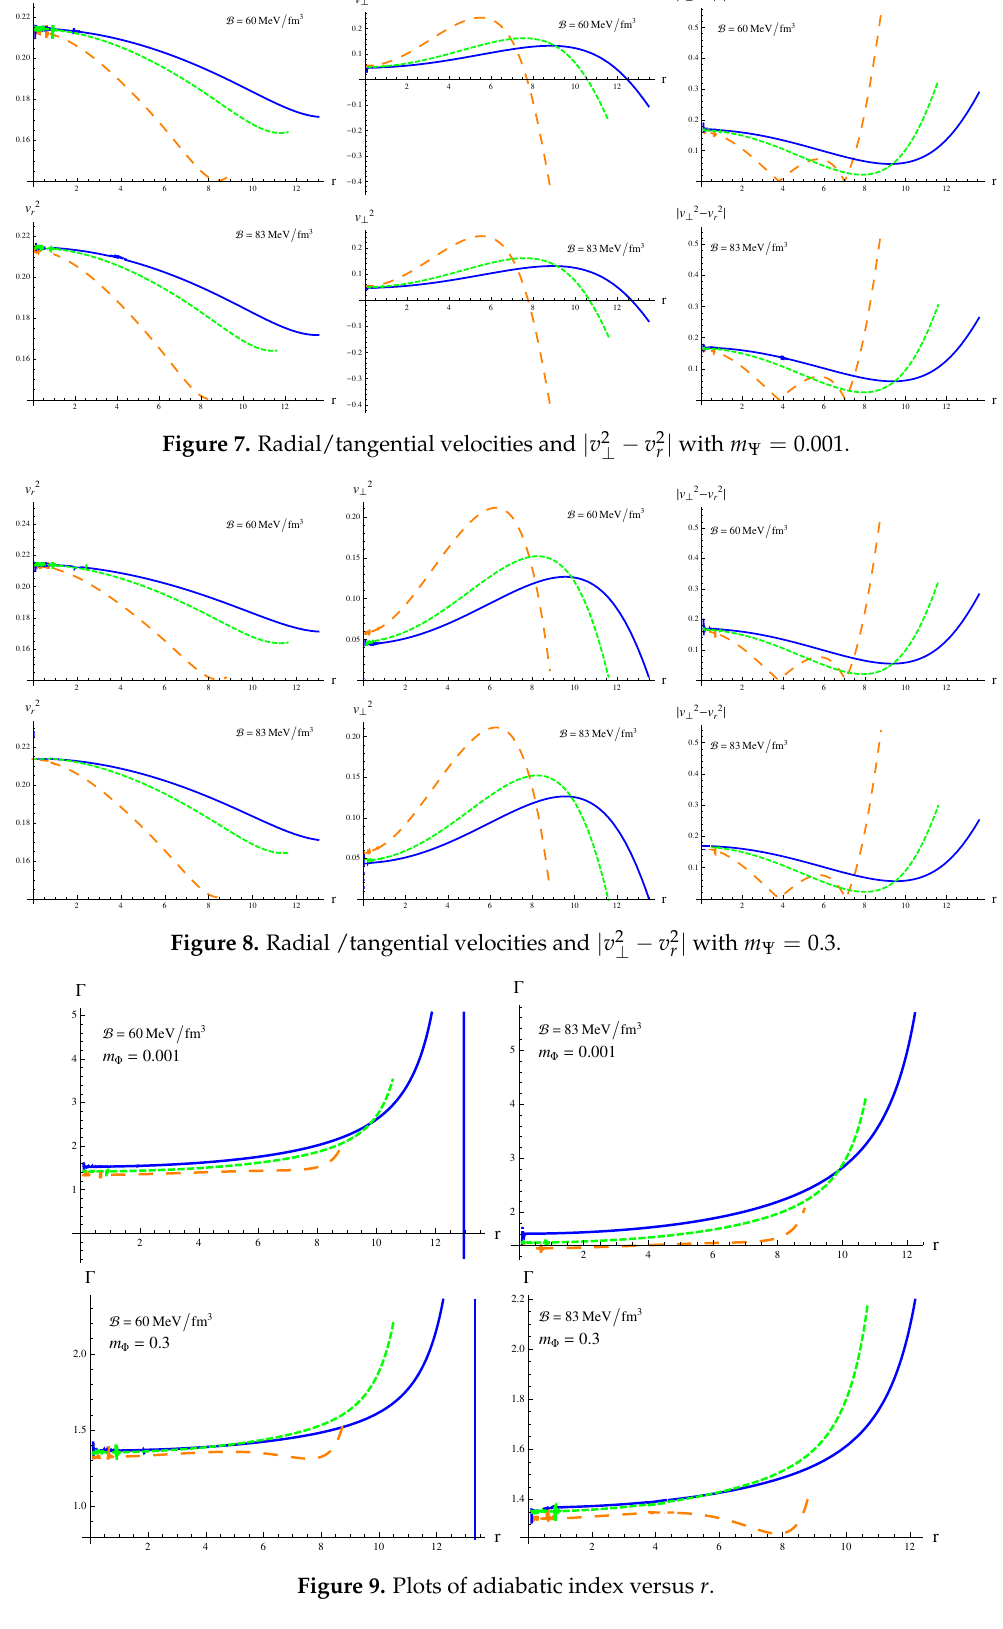
Figure 9. Plots of adiabatic index versus r